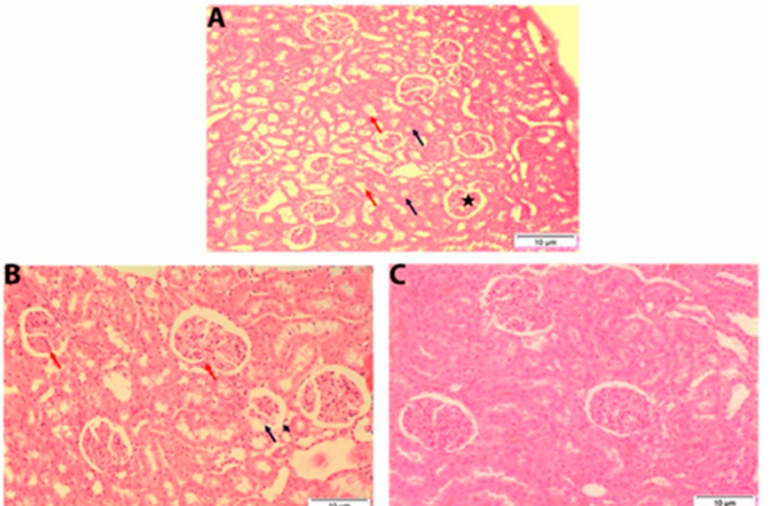
Figure 5. Histological analysis of the kidney tissue in male rat exposed orally to single dose of 250 mg TiSiO 4 NPs/kg b.w. ( A ): Male rat kidney showing a normal glomerulus and Bowman’s capsule (asterisk) intact with simple cuboidal epithelial lining. The proximal tubule (blue arrow) and distal convoluted tubule (red arrow) are also normal. ( B ): Male rat kidney after 7 days post-administration showing that most of the renal corpuscles appeared normal. Notice atrophy (red arrow) or partially degenerated (blue arrow) of some glomeuli that associated with wide urinary space (arrowhead). The renal tubules appeared nearly as control. ( C ): Male rat kidney after 28 days post-exposure showing the renal corpuscles and renal tubules appeared more or less normal. (H & E stain, Scale bar 10 µ m).